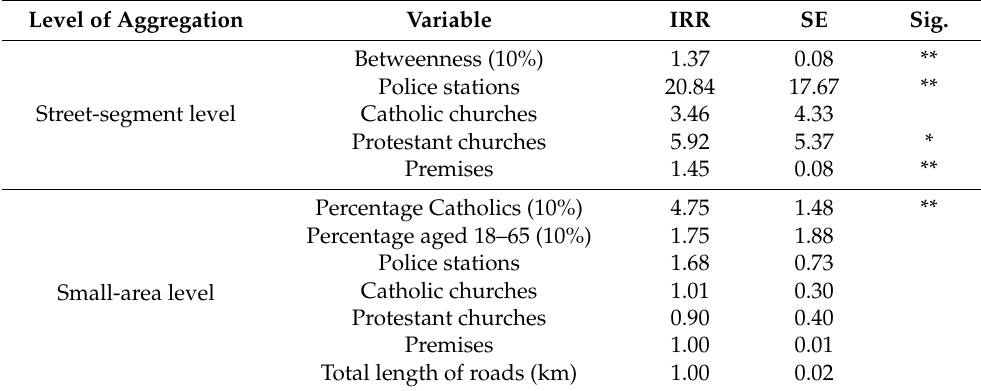
Table A1. Estimates from an OLRE Poisson regression of the location of violent dissident Republican incidents using betweenness calculated with 2 km maximum distance. Level of Aggregation Sig.